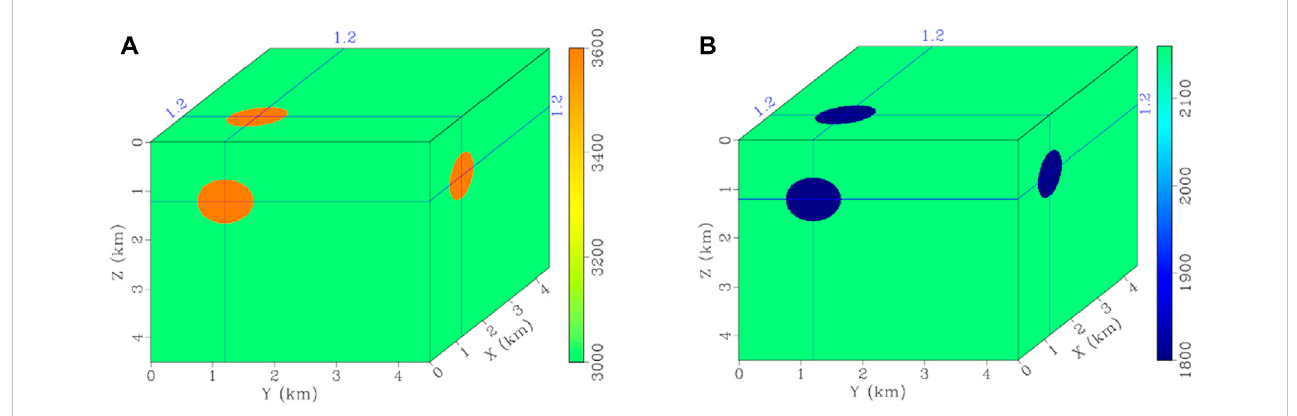
FIGURE 6 Spherical anomaly models of (A) and (B) true P- and S-wave velocity models.